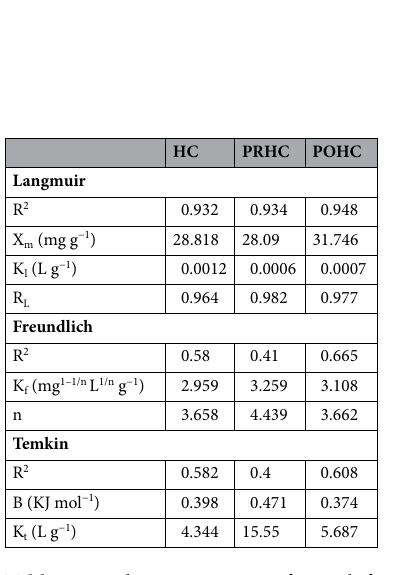
Table 2. Isotherm parameters for Diclofenac adsorption by